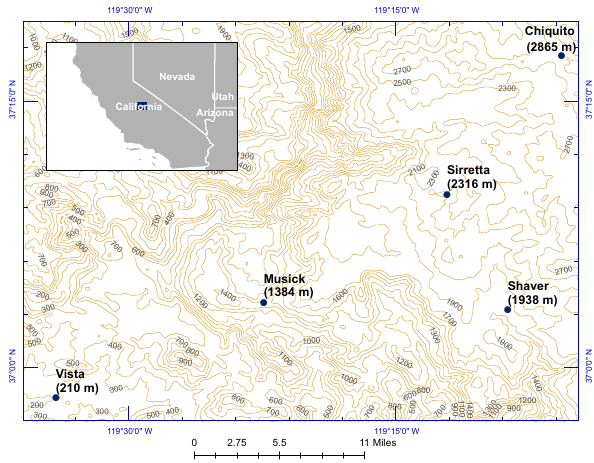
Figure 2. Map of the five sampling sites along elevational transect in the western Sierra Nevada, California (Base map from US Geo- logical Survey,